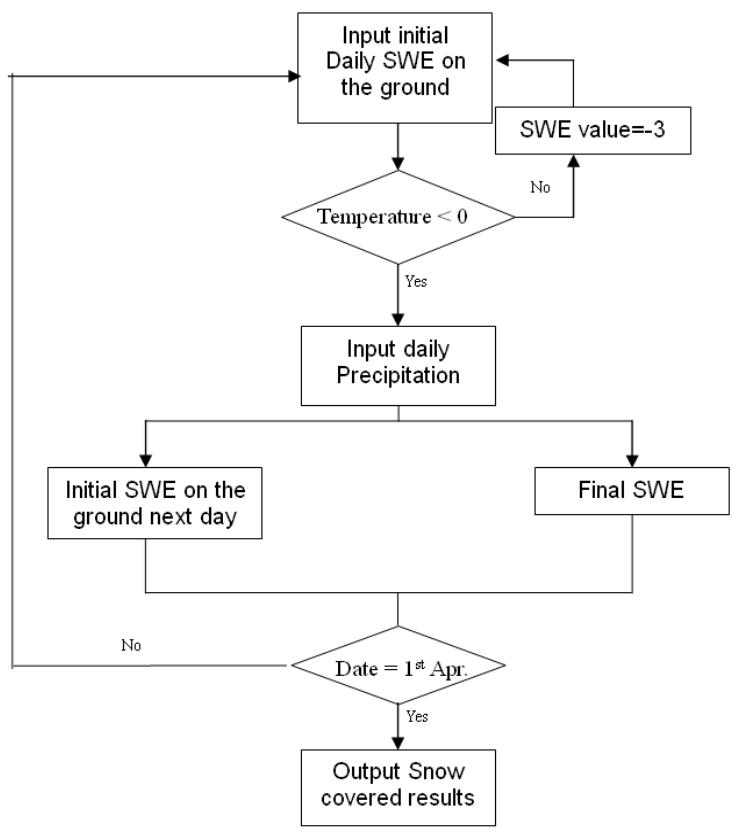
Figure 5. Flow chart of in situ snow cover map